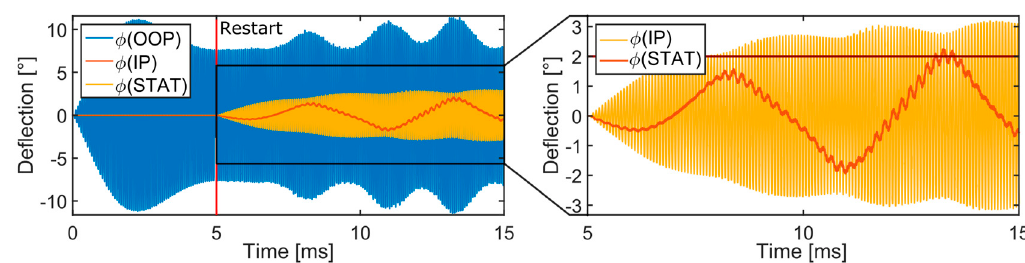
Figure 3. Result of a controlled transient simulation. At first a ramp up of the OOP axis is performed. At t = 5 ms the IP oscillation is activated, leading to an indirect quasistatic deflection of the STAT